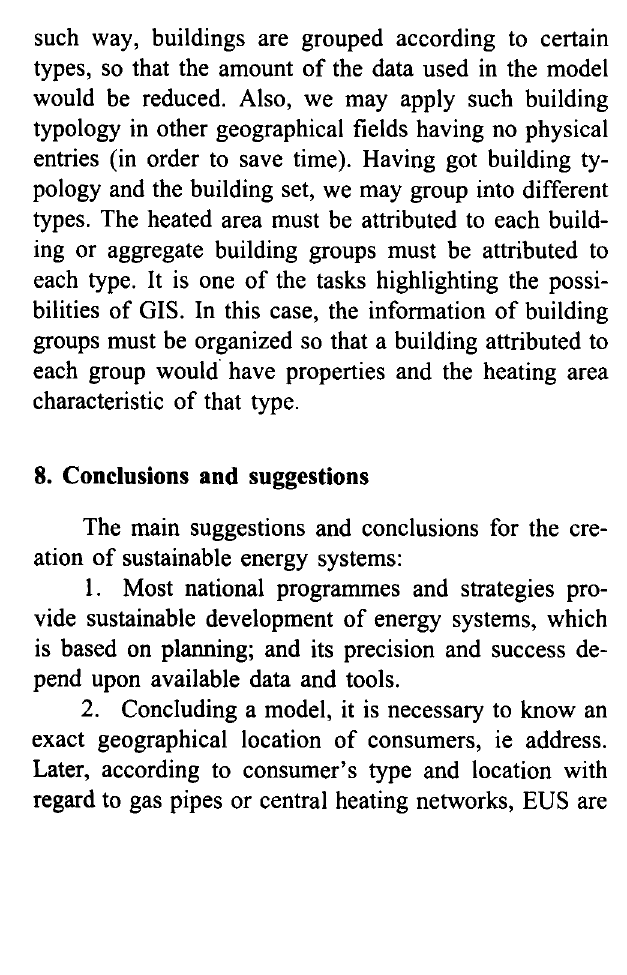
Fig 5. Energy information system for urban